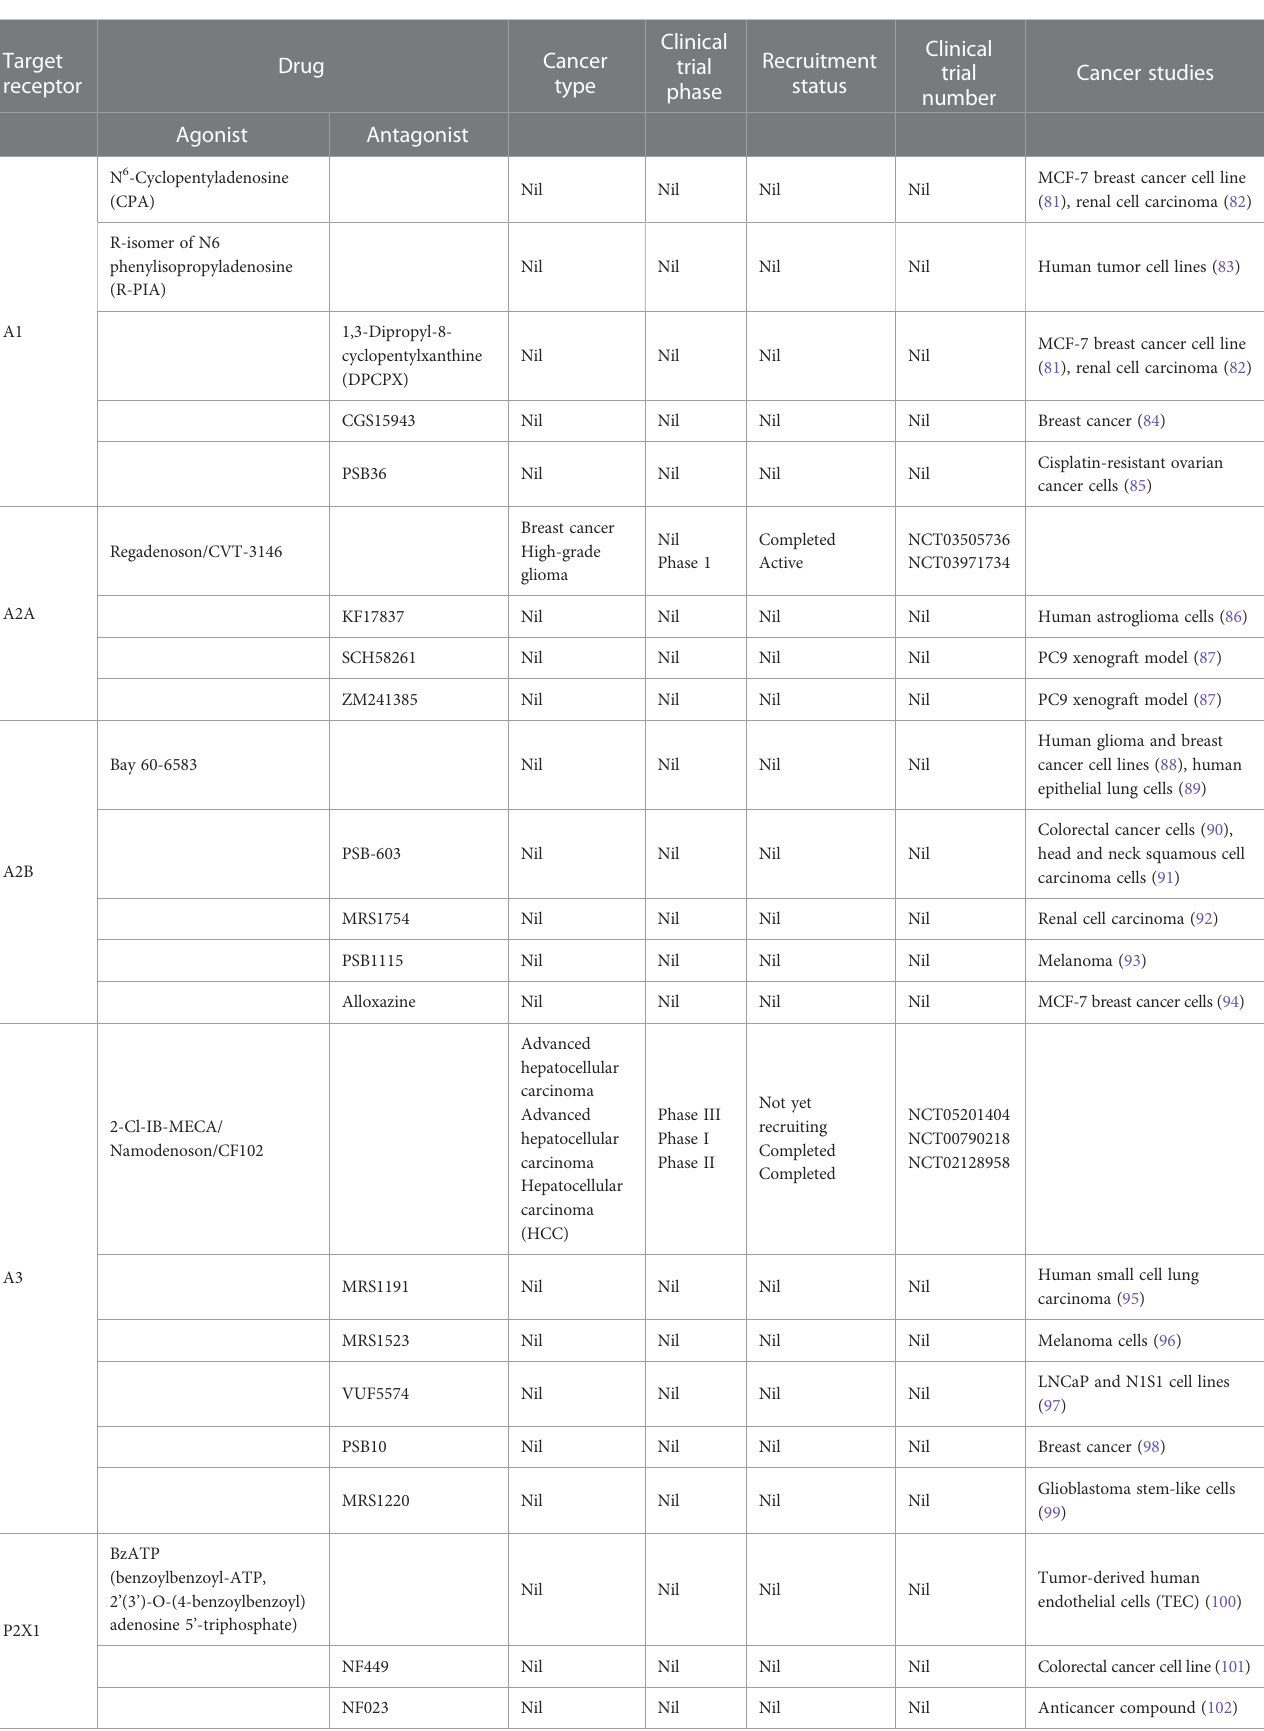
TABLE 1 Clinical trial status and cancer studies of purinoceptors agonists and